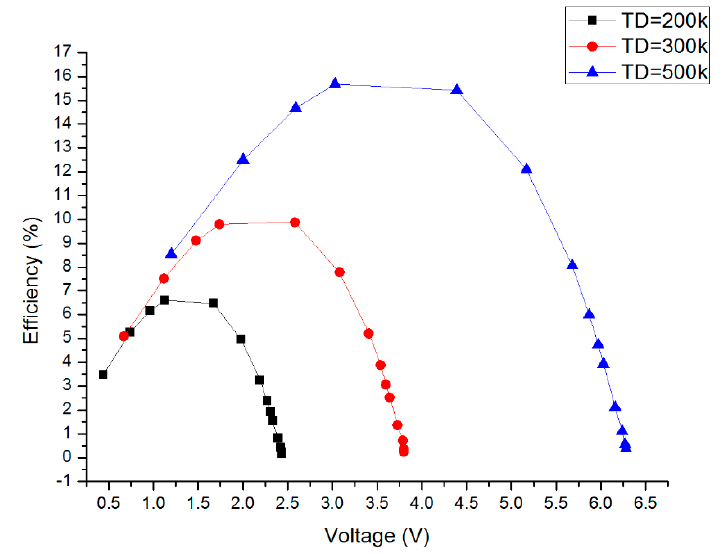
Figure 10. Conversion e ffi ciency versus output voltage.